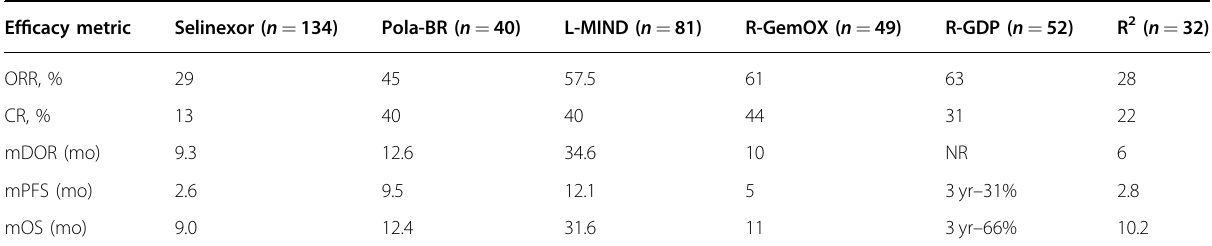
Table 4 Response and outcomes results for regimens for the treatment of relapsed and refractory